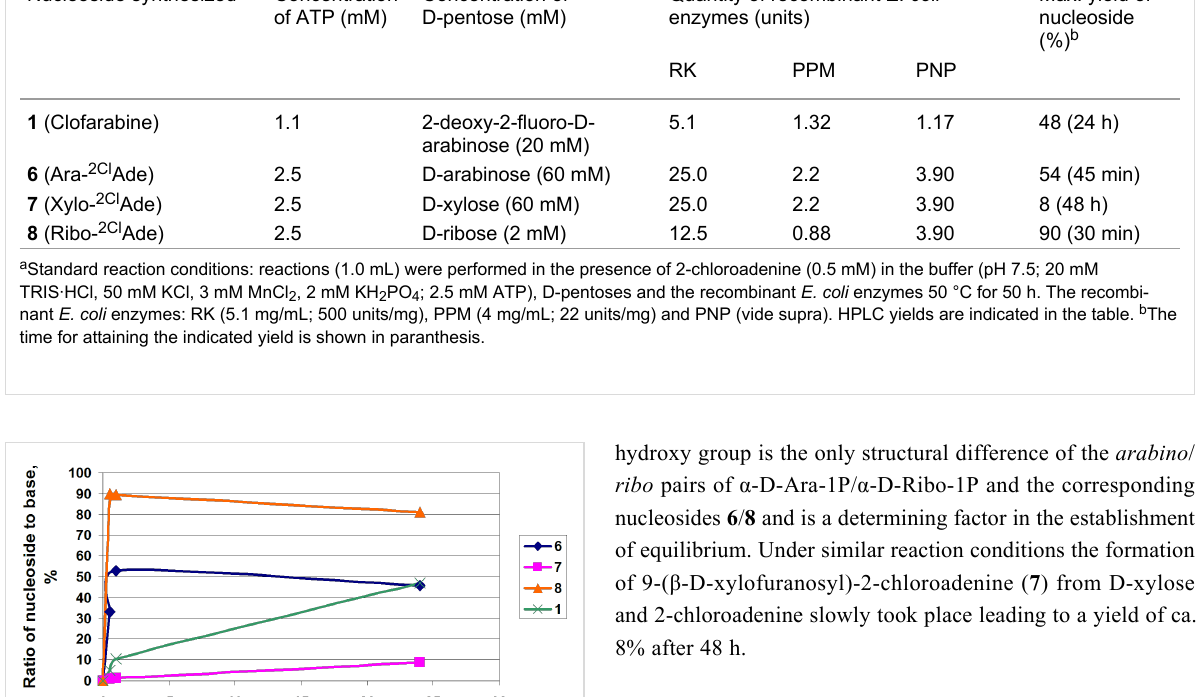
Nucleoside synthesized